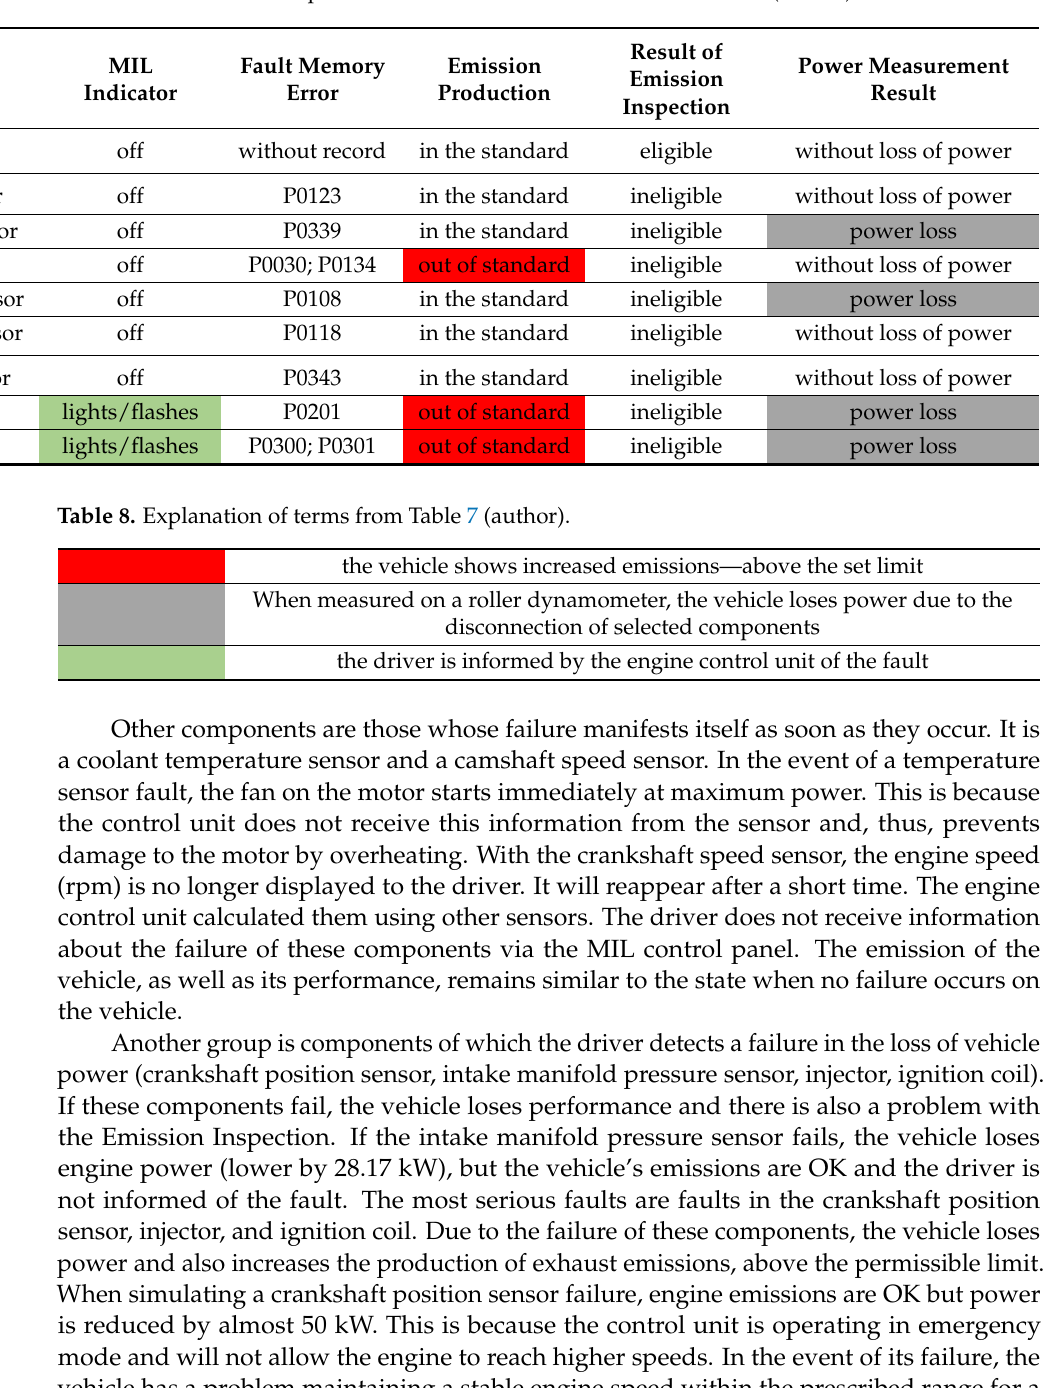
Table 7. Influence of component disconnection on monitored indicators (author).